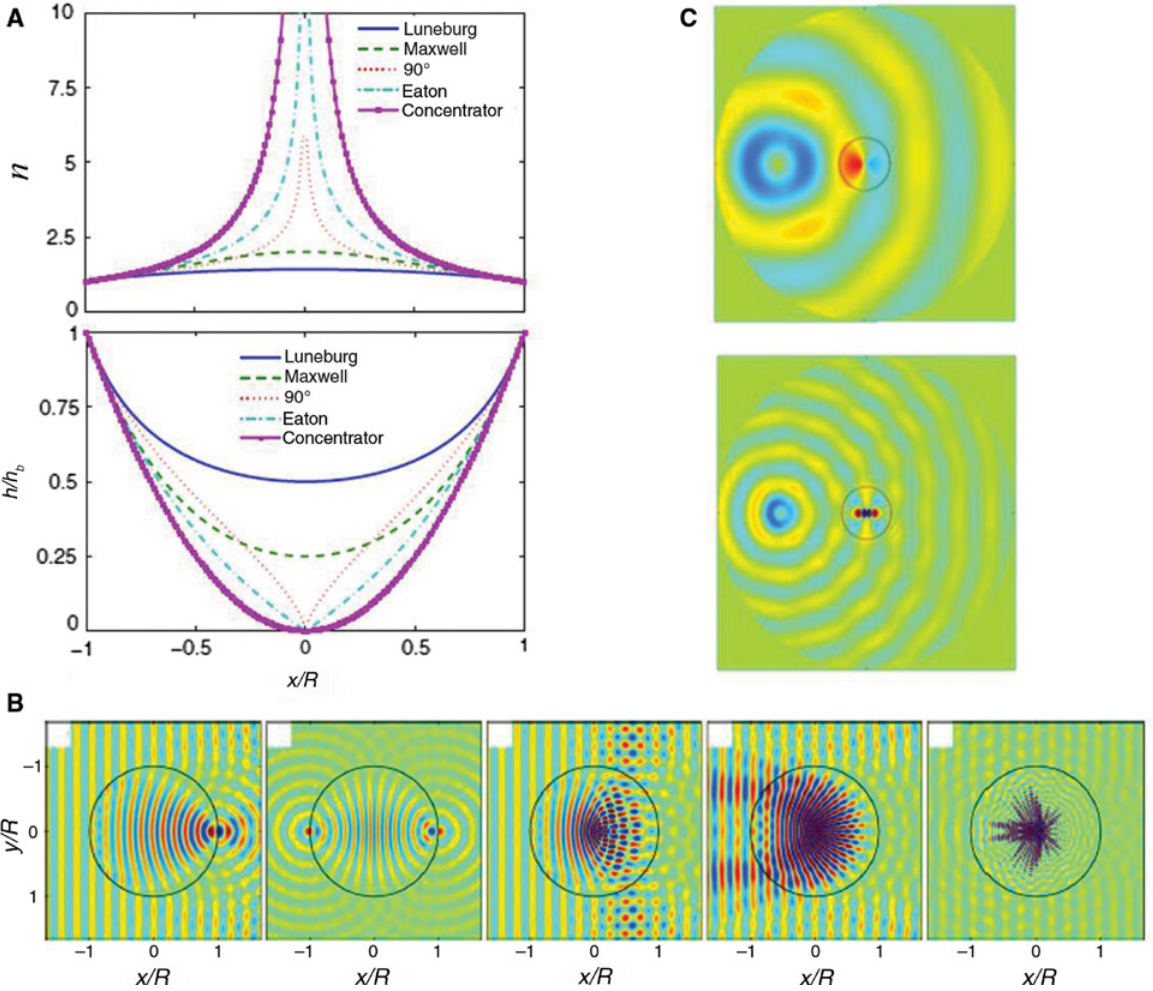
Figure 8: GRIN lenses for flexural waves based on plate’s thickness variations. (A) Refractive index n profiles and corresponding plate’s thickness h/h concentrator lenses. (B) Wave performances of those lenses [24]. (C) Omnidirectional invisible lens for flexural waves based on thickness variation for two different frequencies